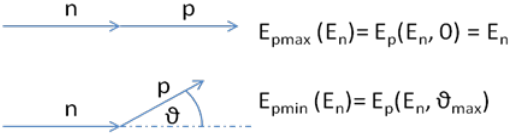
Figure 3. Principle of the dynamic threshold method